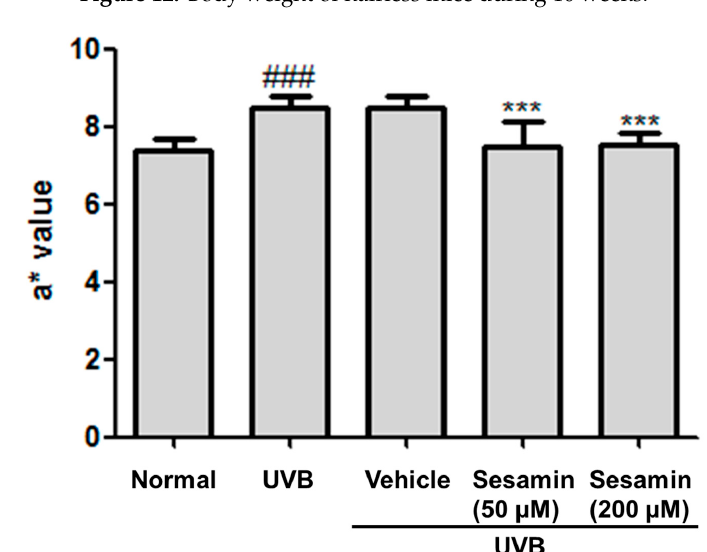
Figure 12. Body weight of hairless mice during 10 weeks.